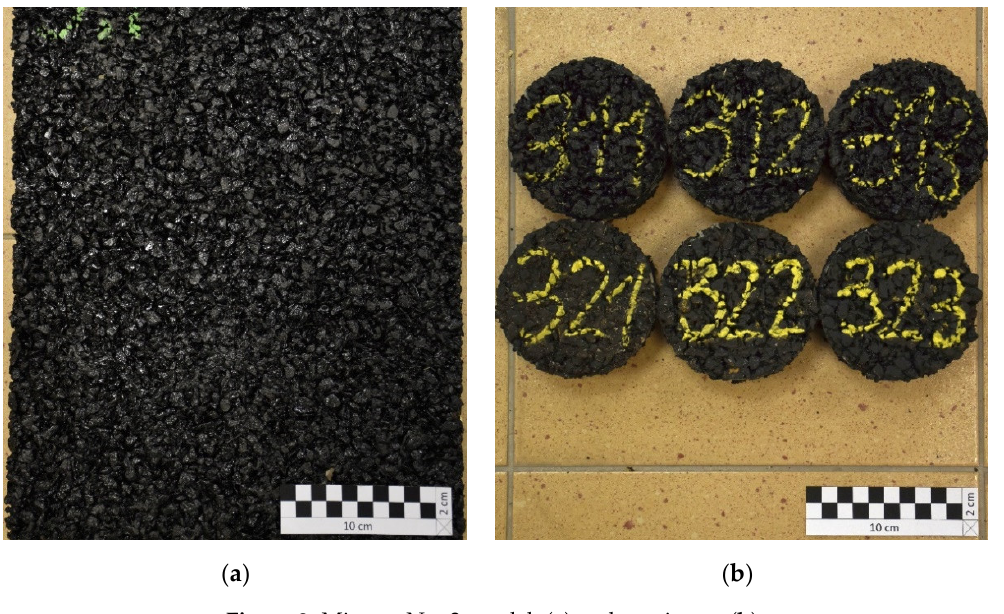
Figure 2. Mixture No. 3—a slab ( a ) and specimens ( b ).